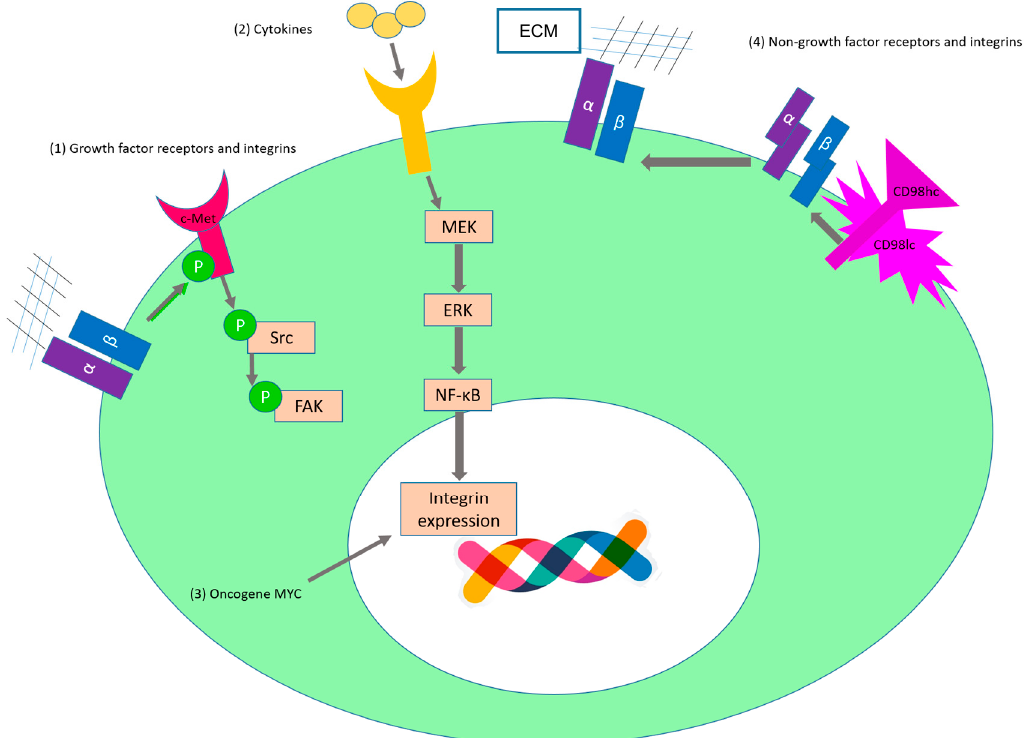
Figure 3. Role of integrins in tumor cell proliferation. (1) The crosstalk between integrins and growth factor receptors (summarized in Table 1) promotes cancer cell proliferation. For instance, in ovarian cancer cells c-Met is activated via phosphorylation upon binding of α 5 β 1 to fibronectin [65]. This activation leads to activation of Src and FAK and promotes proliferation and invasion